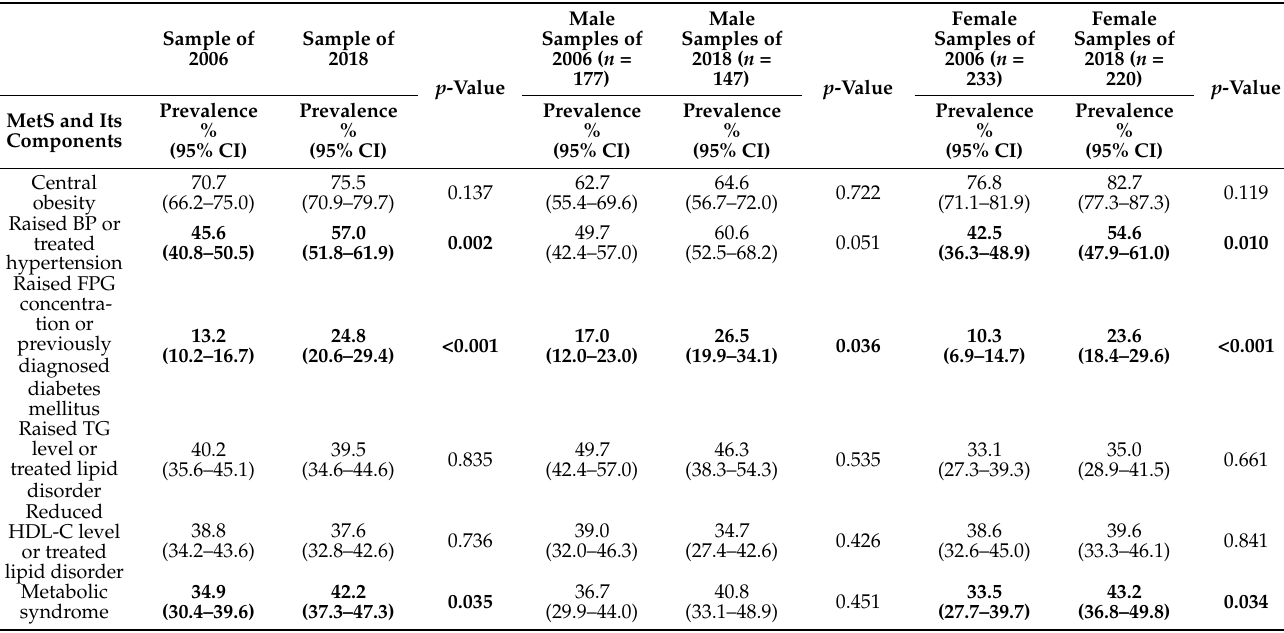
Table 2. Change in the prevalence of metabolic syndrome and its components by sex in the population of Northeast Hungary between 2006 and